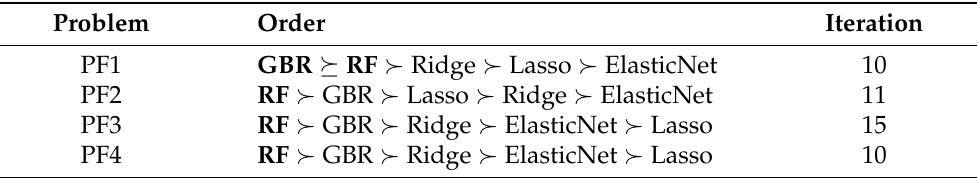
Table 3. Selection of the best ML method for each decision problem. The order of the models and the iteration where the best one (in bold) achieved the stop